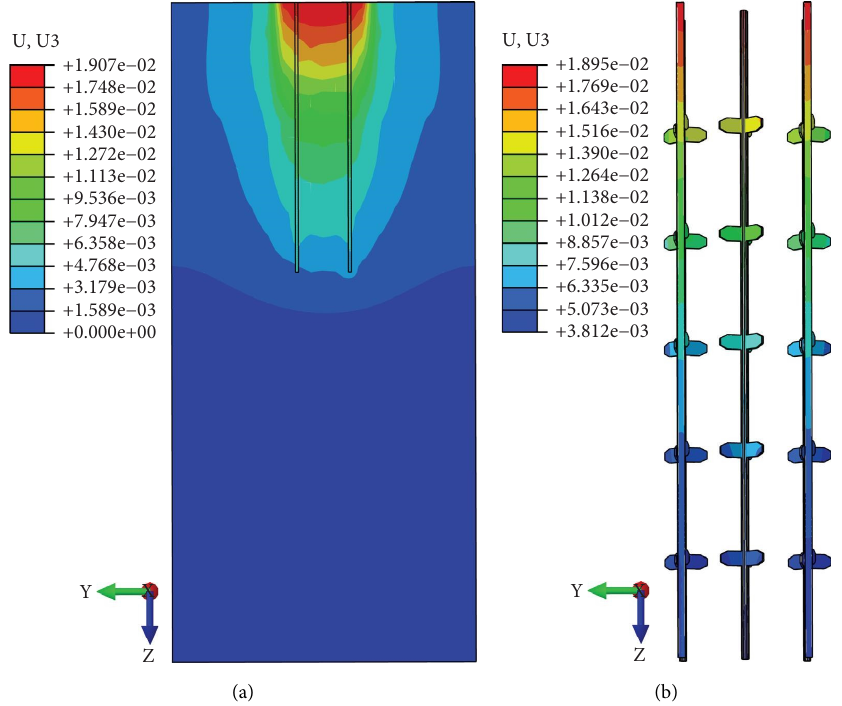
Figure 19: Multipile Composite Foundation Displacement: (a) pile-soil settlement section; (b) pile